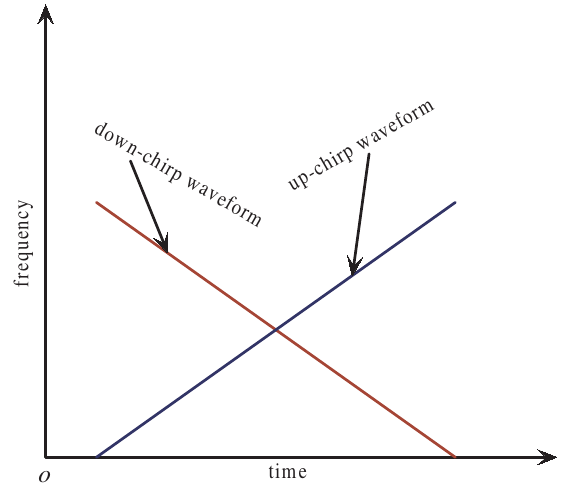
Figure 3. Illustration of down-chirp and up-chirp